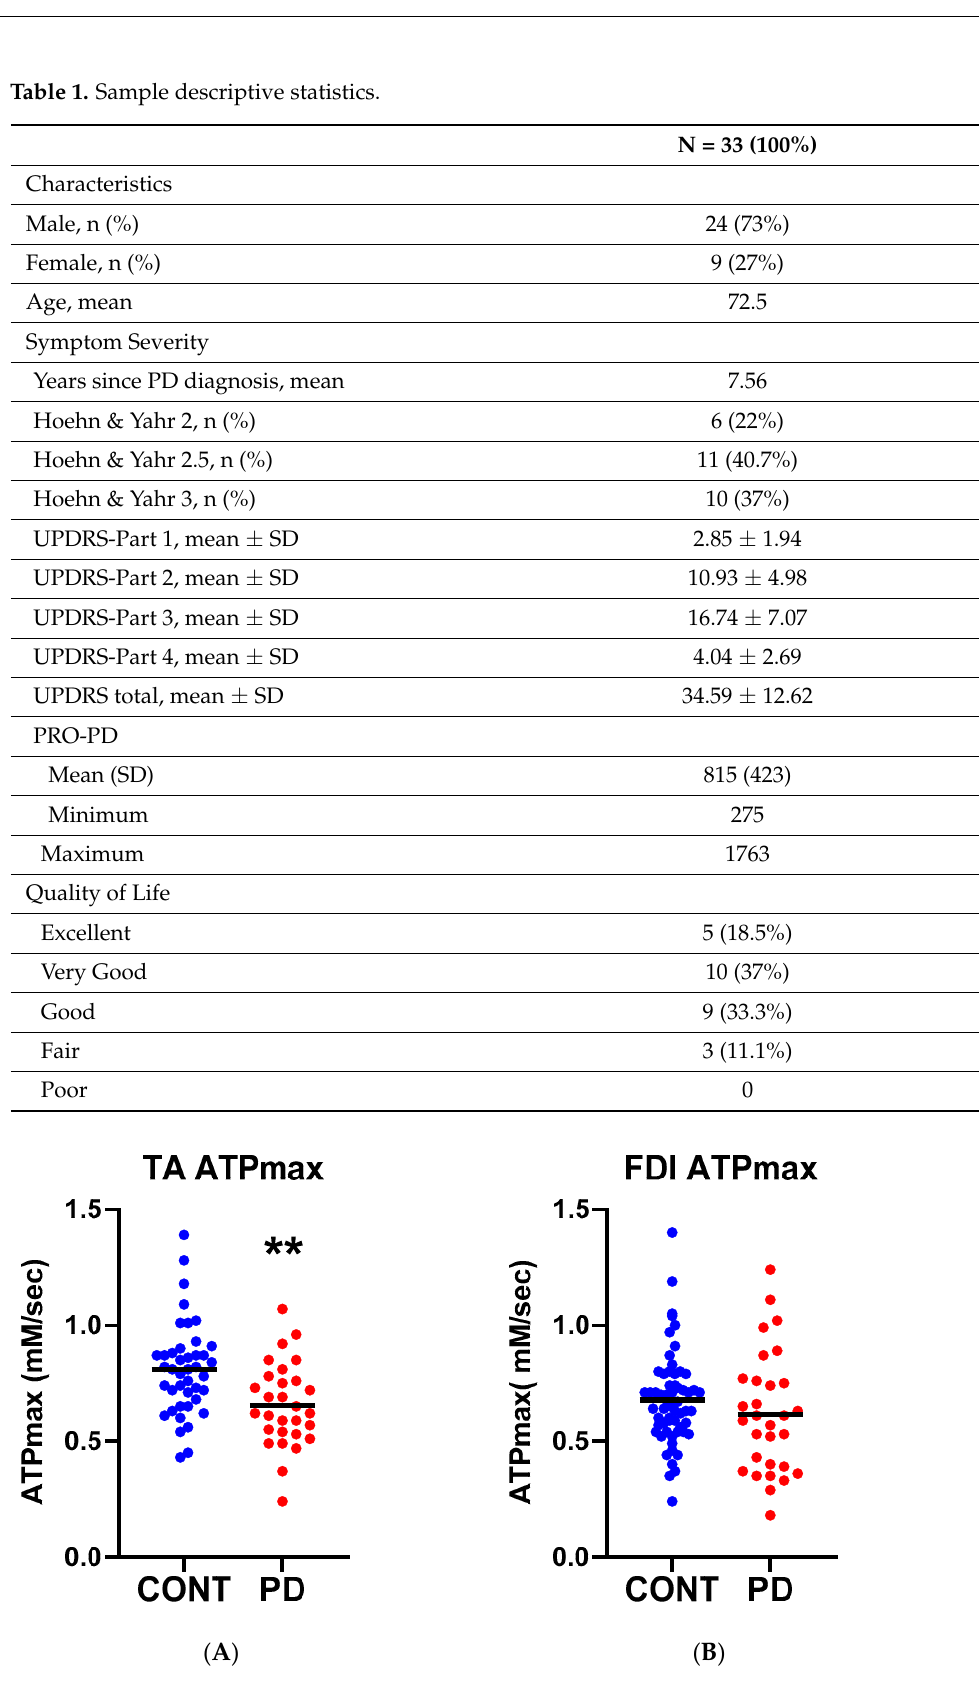
Figure 2. In vivo mitochondrial ATP production. Muscle maximum ATP production (ATPmax) measured using 31 P MRS in the ( A ) leg (tibialis anterior, TA) and ( B ) hand (first dorsal interosseus, FDI). Solid line indicates mean for each group. ** p < 0.01.